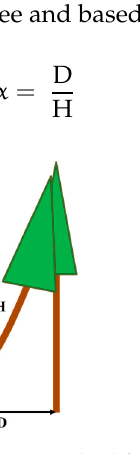
Figure 4. Schematic representation of the calculation method for the inclination angle of the hung up tree ( α ).